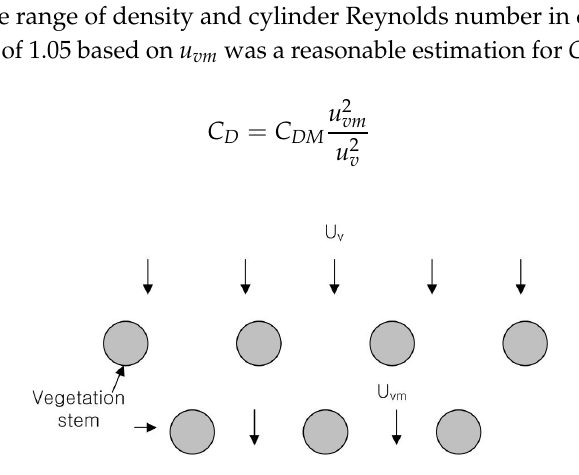
Figure 2. Definition of u v and u vm in vegetation region.